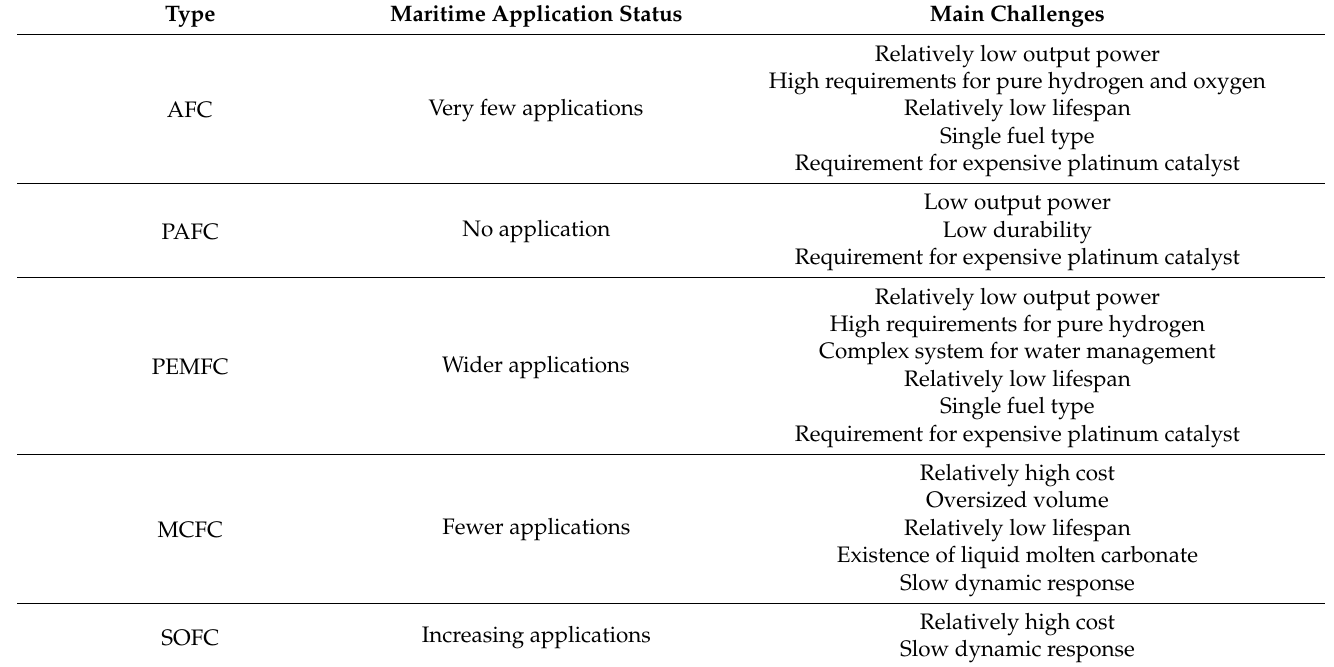
Table 4. Maritime application status of the main types of fuel cell and their challenges [13,15,16,71,